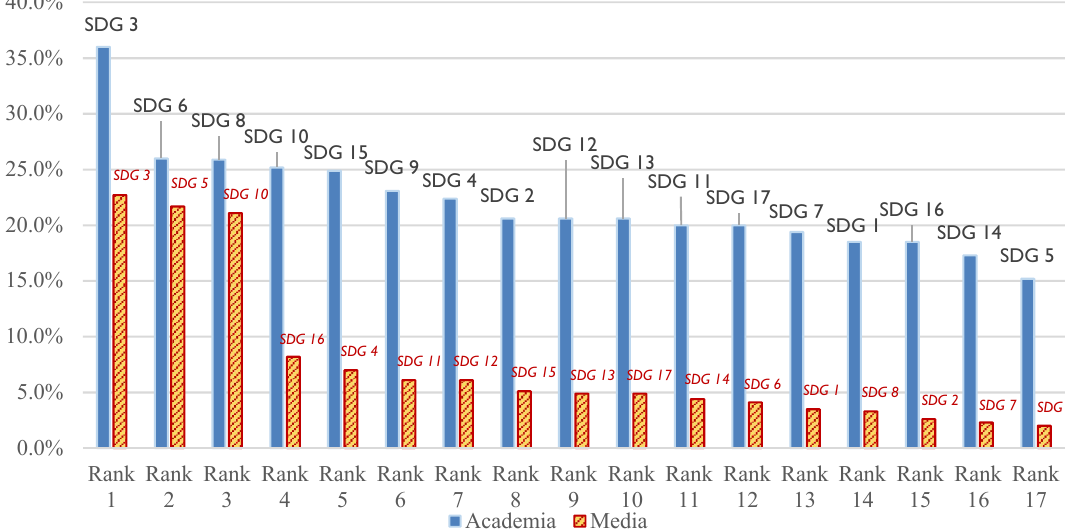
Figure 4. The comparison of academic (left bar) with communication (right bar) industries about the relevance percentage of the top 10 SDGs in 2018 .